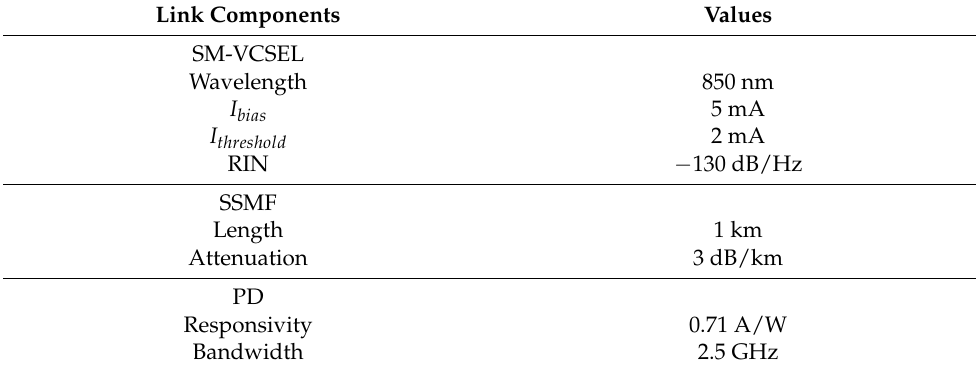
Table 2. Experimental setup parameter